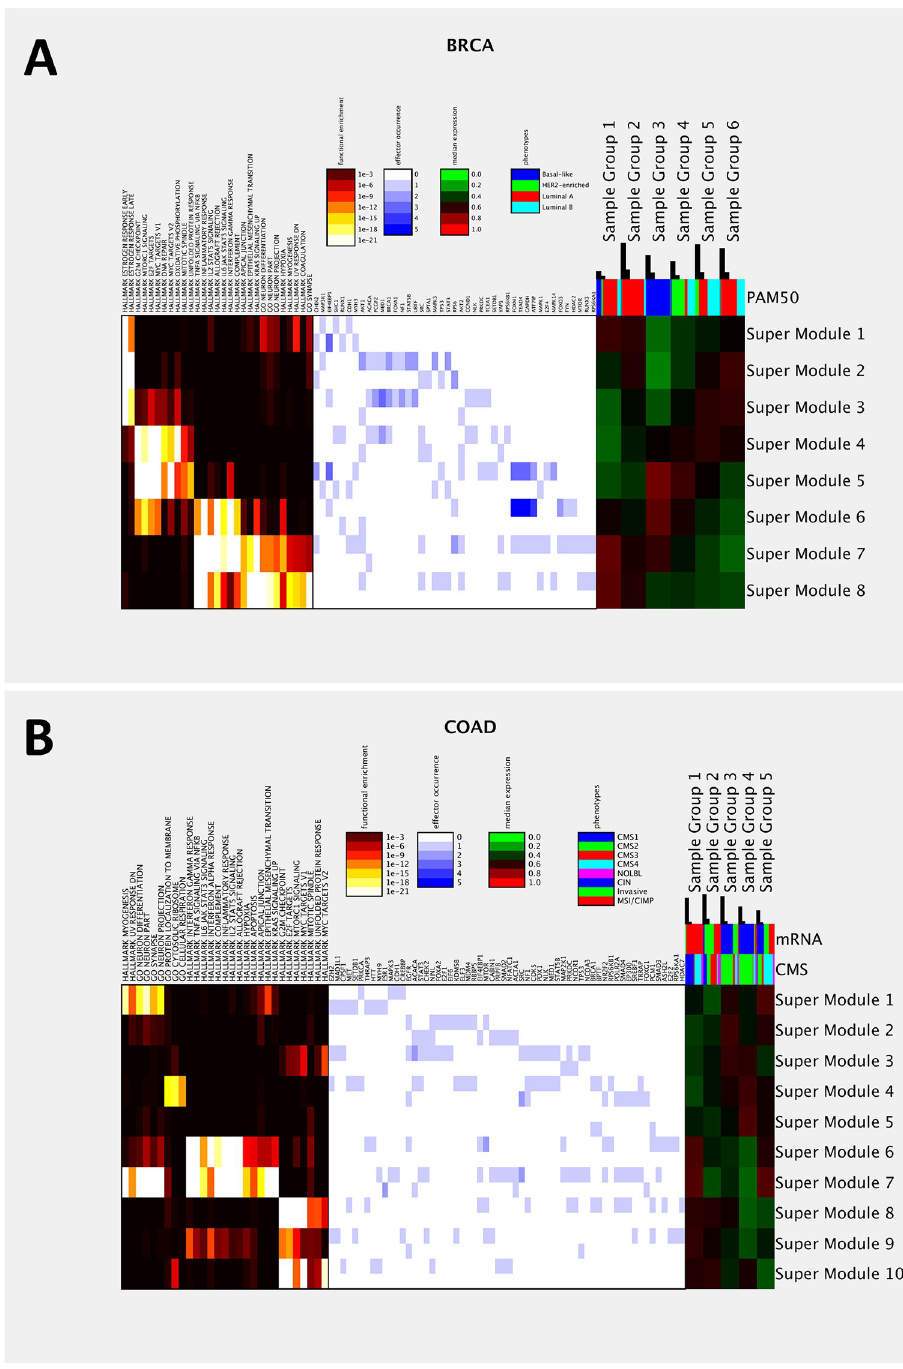
Fig 5. IHAS integrated views in two cancer types. A : An integrated view of BRCA data. The left panel displays the FDR-adjusted hyper-geometric enrichment p-values of selected Gene Sets in each Super Module. The middle panel displays the occurrences of selected effectors (hubs in the Consensus Artery Network) in each Super Module. The occurrences of positive and negative associations are shown in the upper and lower portions of each grid. The right panel displays the median combinatorial expression of each Super Module in each Sample Group. The colored bars above the right panel shows the composition of clinical phenotypes (PAM50 subtypes for BRCA) in each Sample Group. The black bars above indicate the total number of patients and the number of patients surpassing 5-year survival times in each Sample Group. B : An integrated view of COAD data. Legend follows panel A .